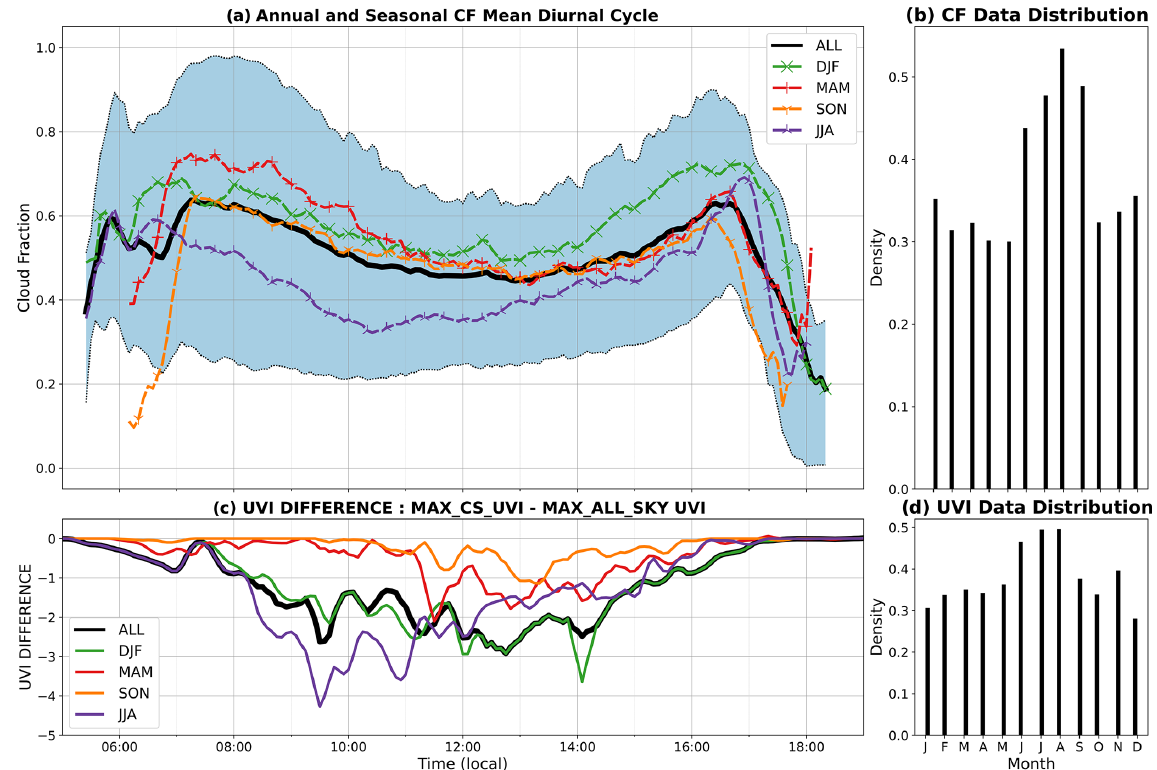
Figure 8. (a, b) Diurnal cycle of CF at Saint-Denis. Annual mean CF is in black, and first and third quartiles delimit the blue shaded area. Seasonal mean is in green (DJF), red (MAM), orange (SON), and purple (JJA). (c, d) Diurnal cycle of the difference between maxima of UVI in clear-sky conditions and in all-sky conditions at Saint-Denis. Annual max UVI differences are in black. Seasonal max UVI differences are in green (DJF), red (MAM), orange (SON), and purple